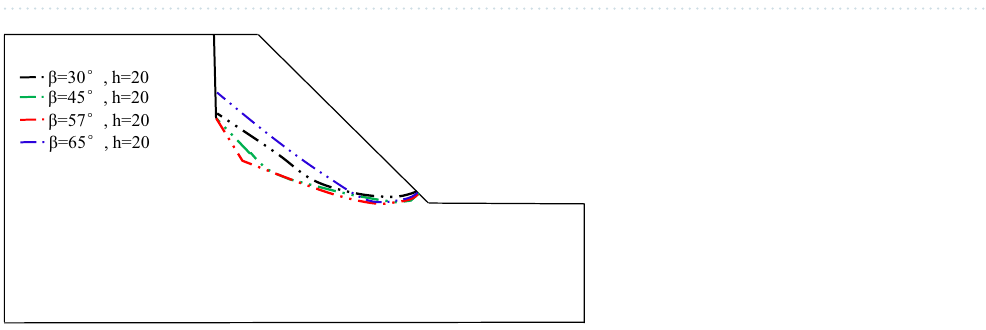
Figure 9. Main sliding surface of slopes with different dip angles of diagonal